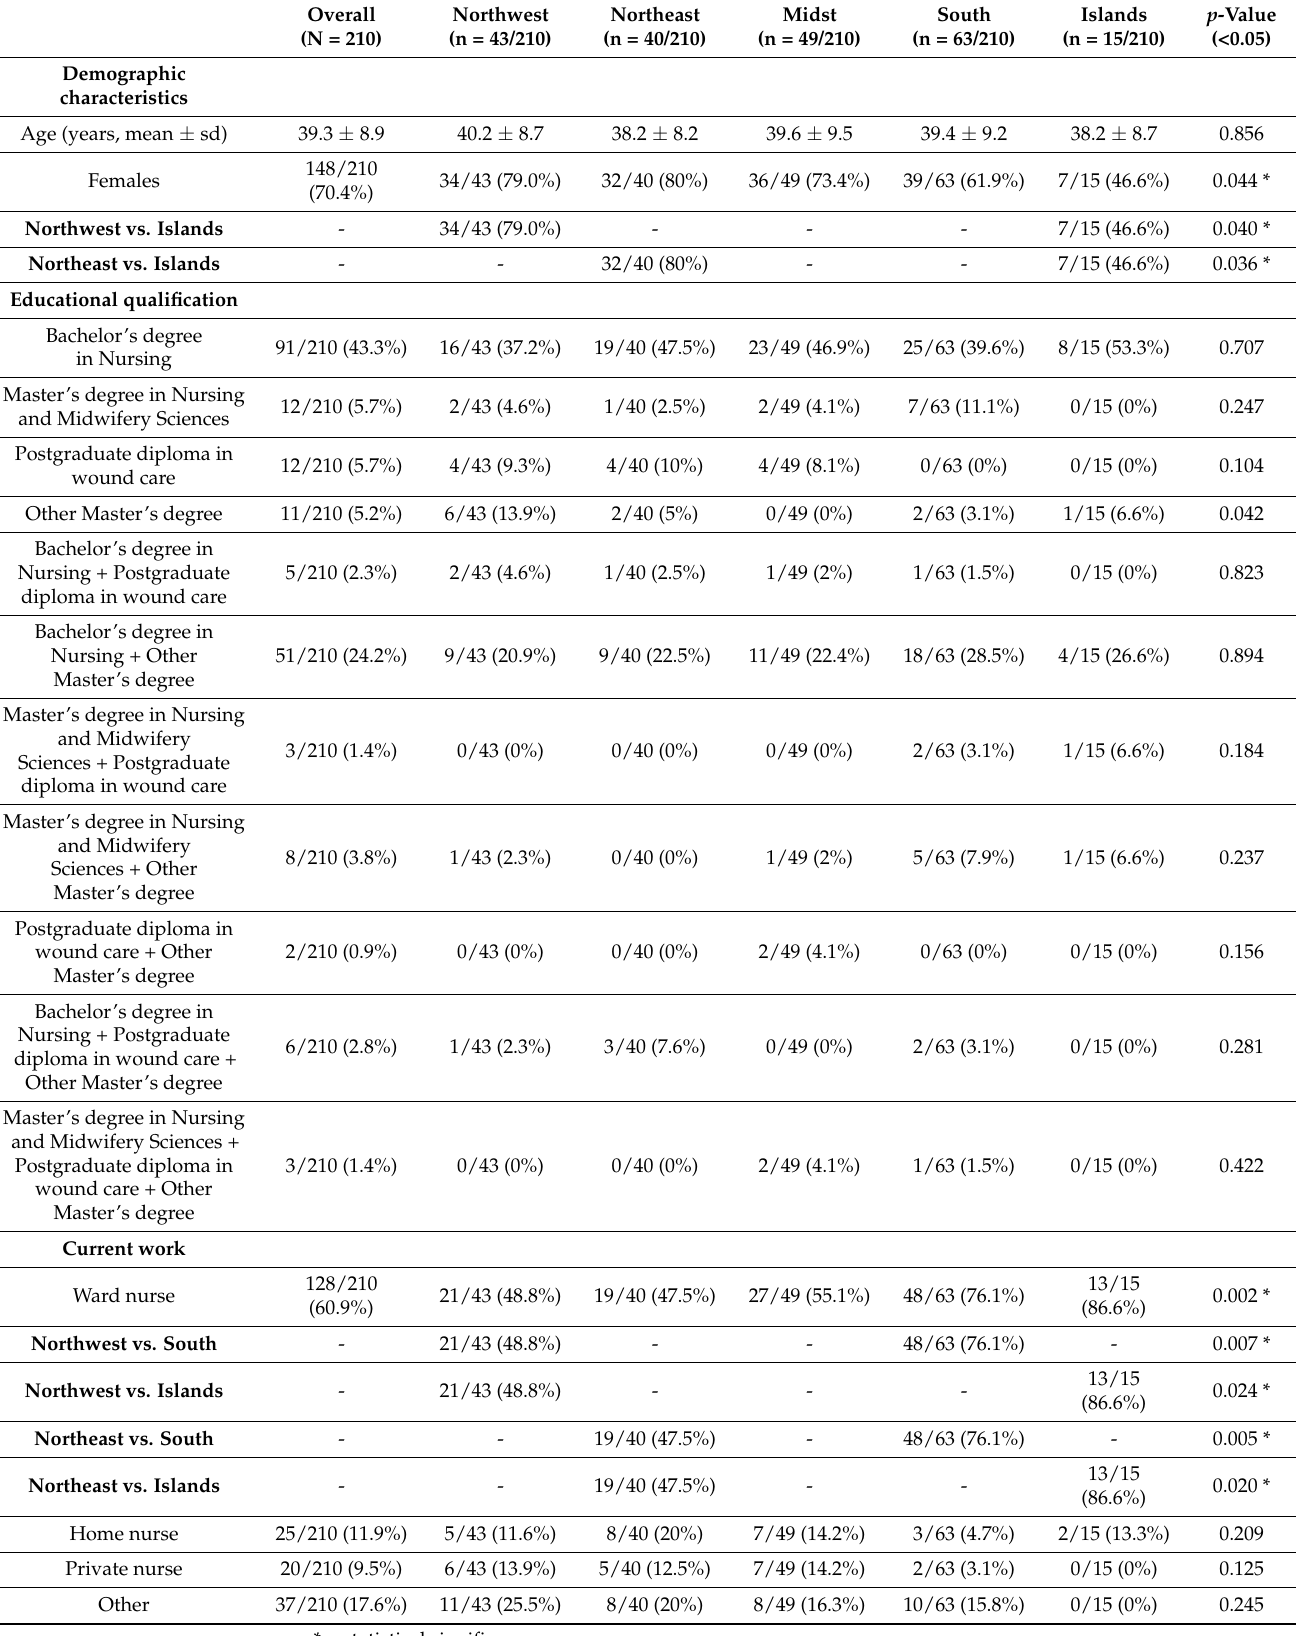
Table 1. Population